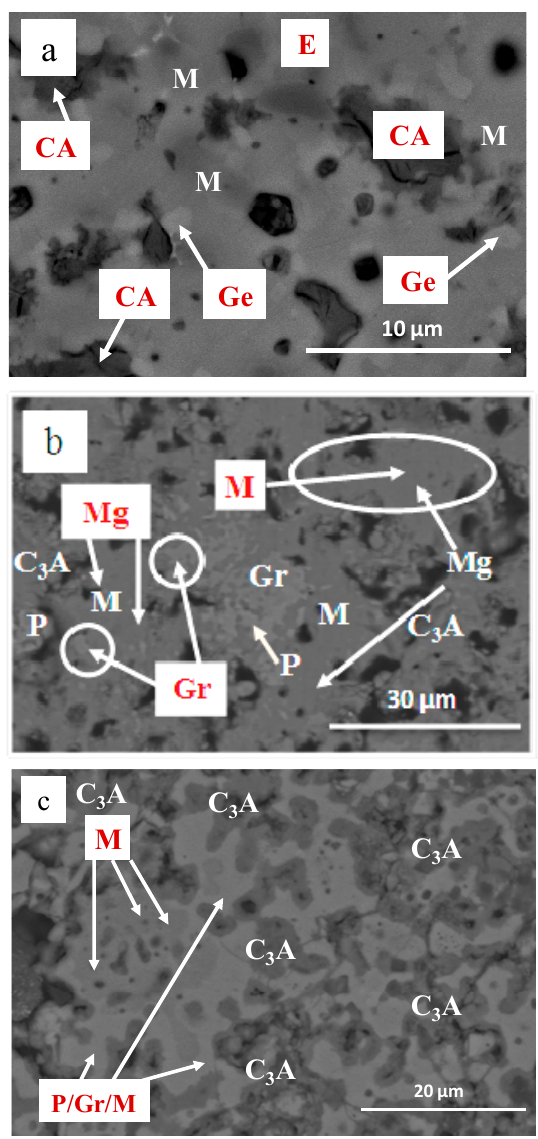
Figure 3. SEM imagen (backscattered electrons) of sinters obtained at 1300 °C; ( a ) Al 2 O 3 /CaO 1:1 Al3 S; ( b ) Al 2 O 3 /CaO 1:2 Al3 2S y ( c ) Al 2 O 3 /CaO 1:3 Al3 3S. (CA = calcium aluminate, M = mayenite or C 12 A 7 , E = spinel, Ge = Al 2 Ca 2 O 7 Si, C 3 A = calcium trialuminate, Gr = Ca 3 Al 2 (SiO 4 ) 3 , Mg = MgO y P = Al 1.95 Fe 0.49 Mg 2.65 O 12 Si 2.91 ).